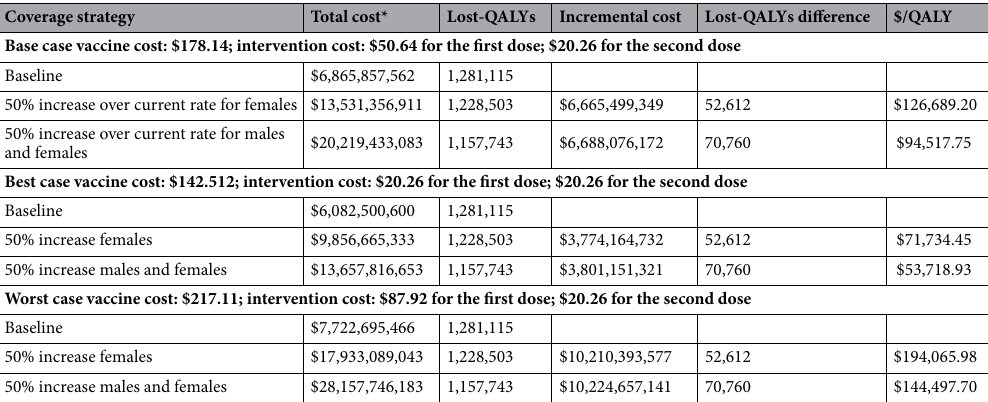
Table 3. Incremental cost per quality-adjusted life year (QALY) gained by vaccination for vaccine uptake rate 50% increase scenario. (1) Discount rate is 0.03; (2) Costs reported in 2018 USD; (3) Planning horizon is 100 years; (4) Female and male vaccination includes age 13 to 26 years. *Note that "Total cost" denotes the sum of vaccination cost, promotion cost and treatment cost.